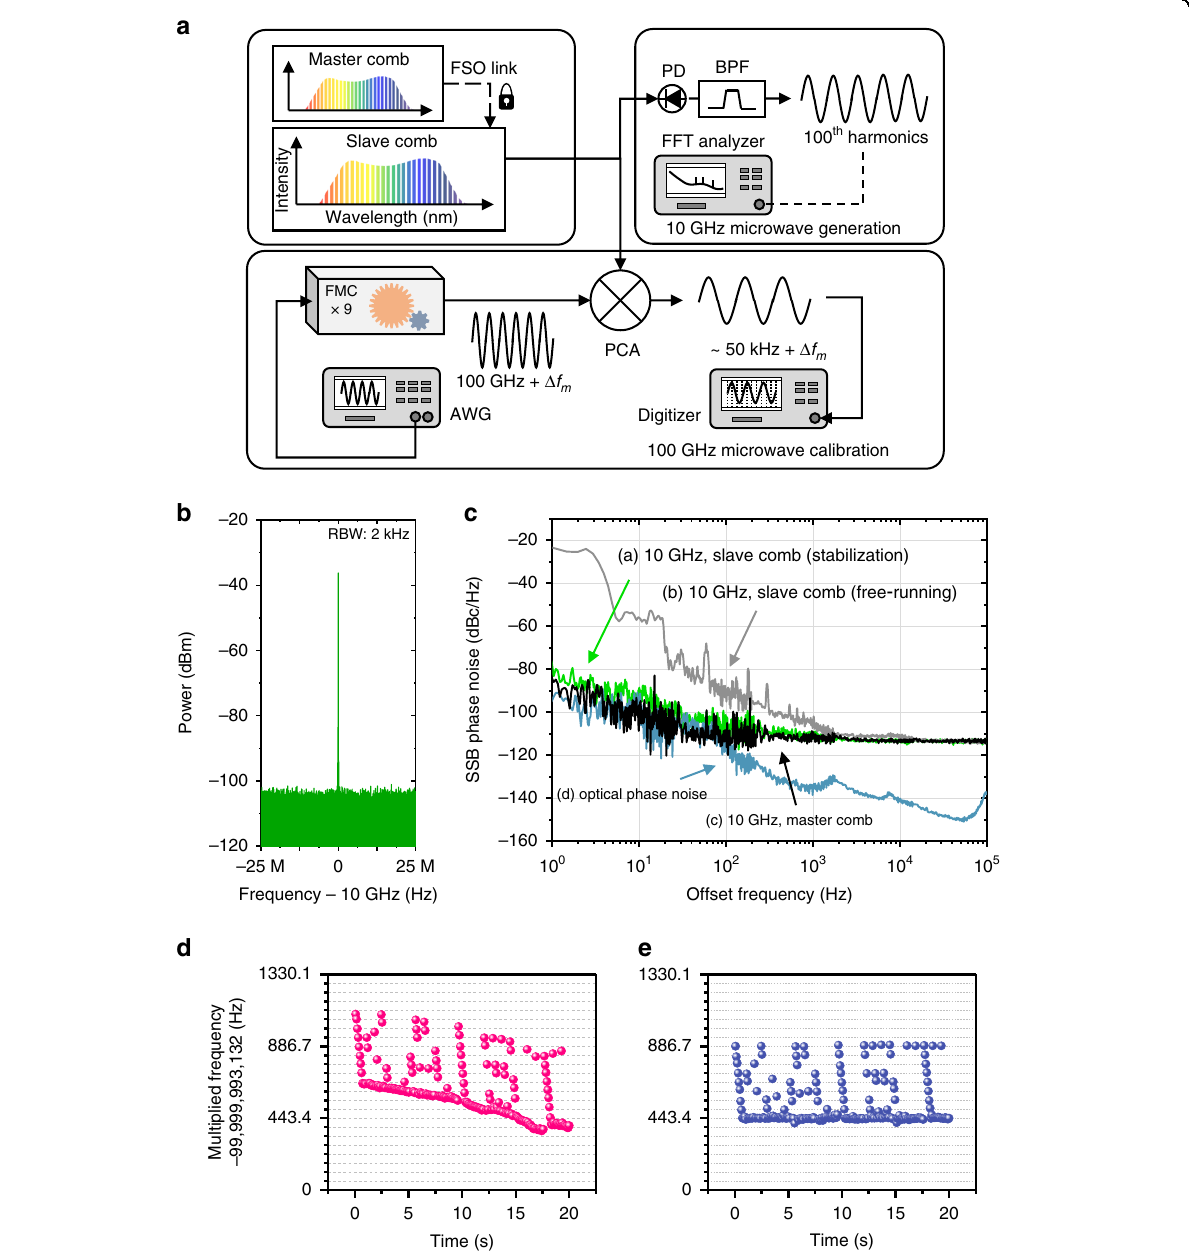
Fig. 4 Comb-referenced generation of 10 GHz microwaves and calibration of 100 GHz. a Hardware con fi guration. b RF spectrum of generated 10 GHz microwave. c Phase noise spectra of 10 GHz microwaves generated with different conditions. d , e Calibration of 100 GHz microwaves with the slave comb in a free-running state ( d ) and after stabilization ( e ) for comparison. BPF Bandpass fi lter, PD Photodetector, AWG Arbitrary waveform generator, FMC Frequency multiplier chain, PCA Photo-conductive antenna, and RBW Resolution